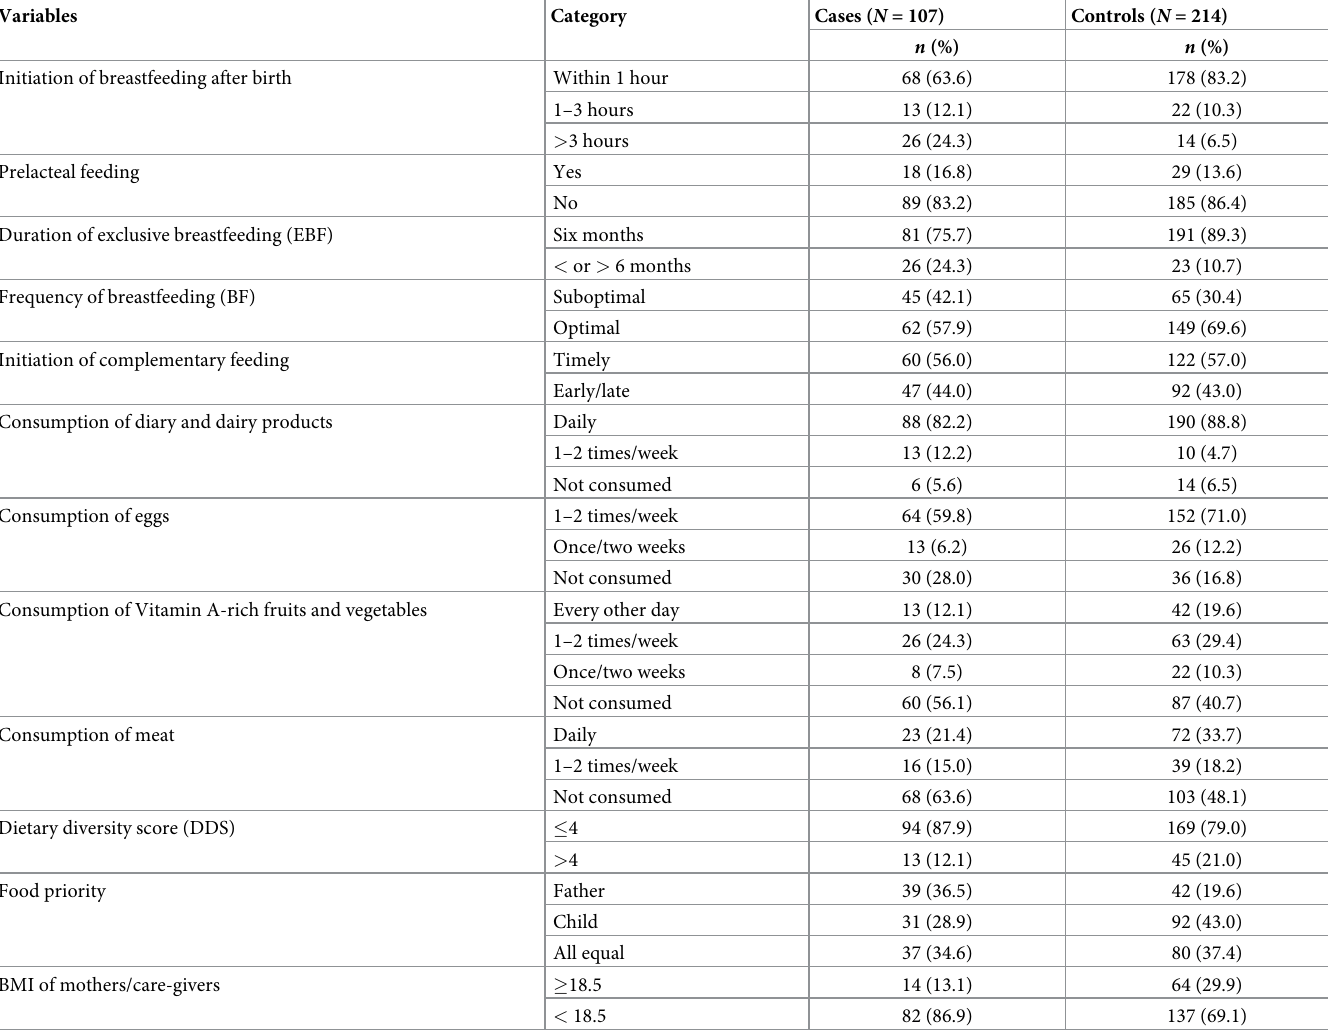
Table 2. Practices for feeding children 6–59 months old in Kemissie City Administration, northeastern Ethiopia, January to April